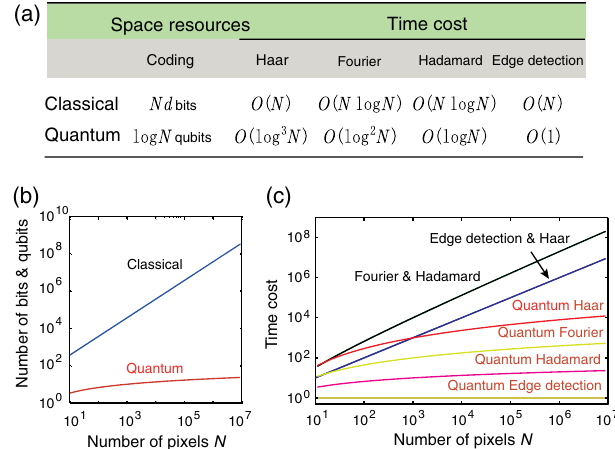
FIG. 2. (a) Comparison of resource costs of classical and quantum image processing for an image of N ¼ M × L (i.e., n ¼ log 2 N ) pixels with d -bit depth. (b) Space resources com- parison. Top (bottom) curve represents classical (quantum) algorithms, with d ¼ 36 . (c) Time cost comparison. The two curves at the top of this graph represent classical algorithms, and the four curves (Quantum Haar, Quantum Fourier, etc.) at the bottom represent quantum